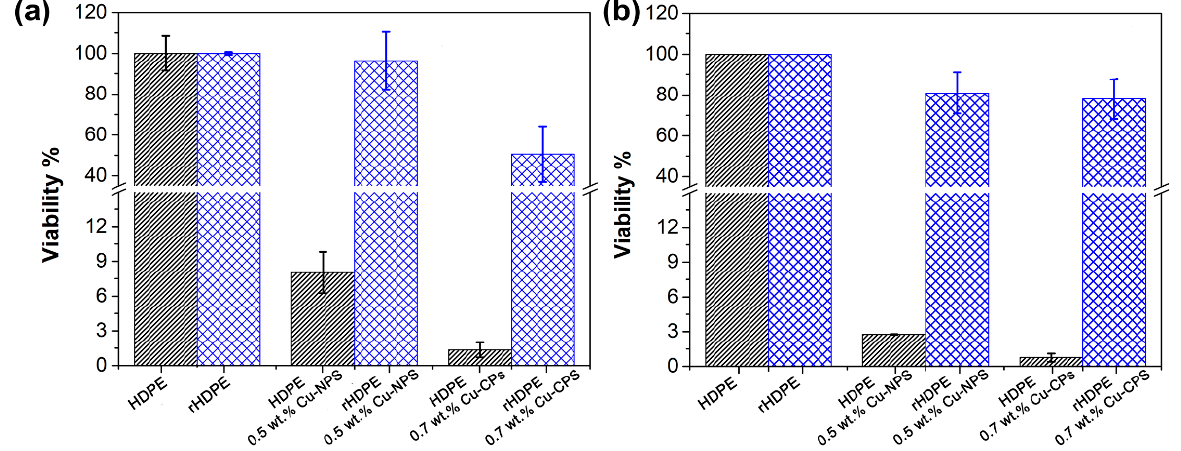
Figure 8. Comparison of the bacterial viability of ( ) virgin HDPE and ( ) recycled HDPE sam-ples: ( a ) E. coli and ( b ) S. aureus .